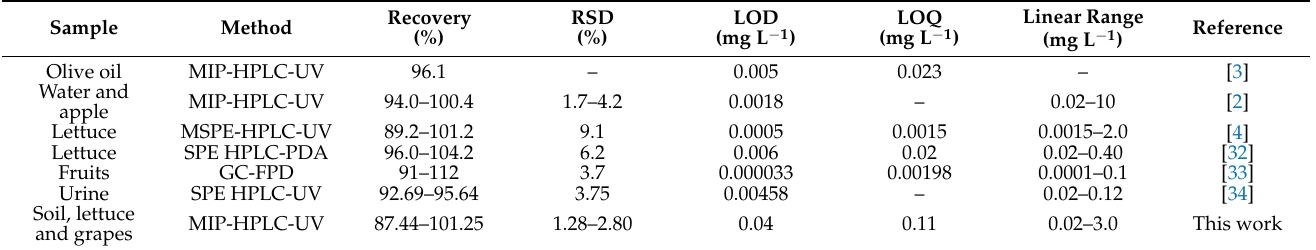
Table 4. Comparison of the present work with previously reported methods for FNT